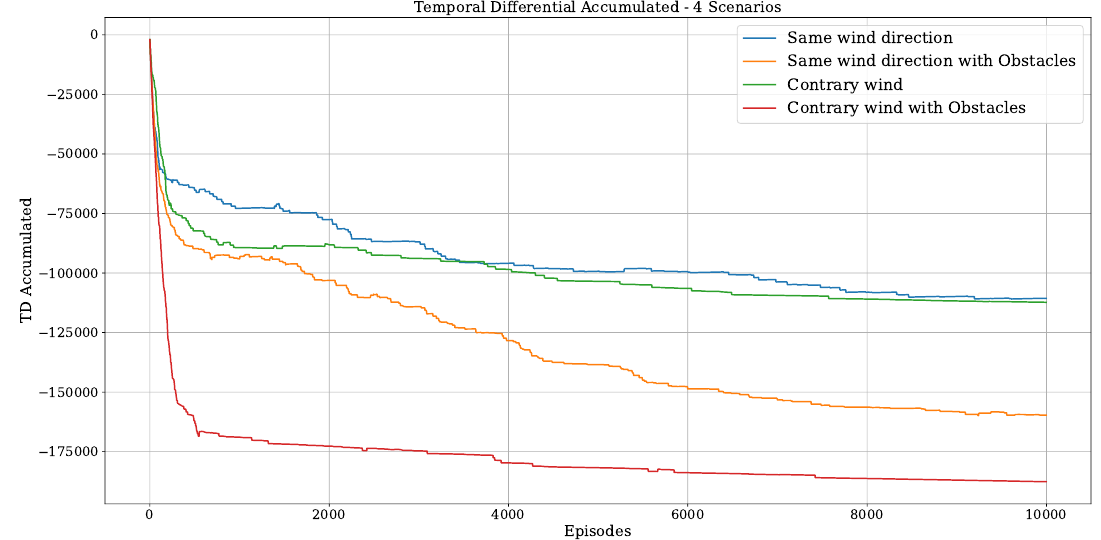
Figure 14. Accumulated Temporal differential error for scenarios Figures 11a,b and